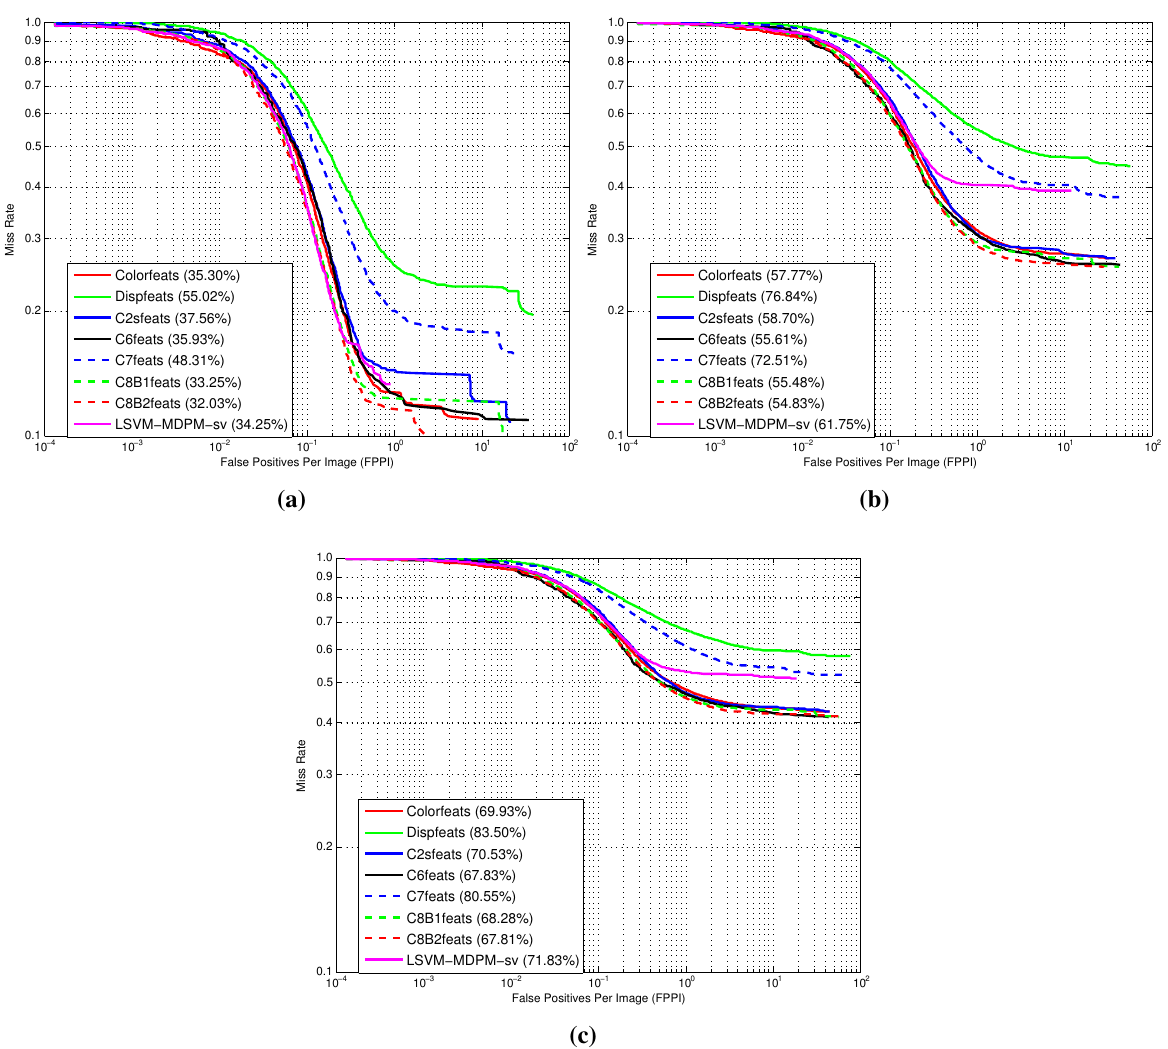
Figure 9. Comparison of the 3D-aware features log-average miss rate (LAMR) performance for the class ‘car’. ( a ) Easy; ( b ) moderate; ( c )